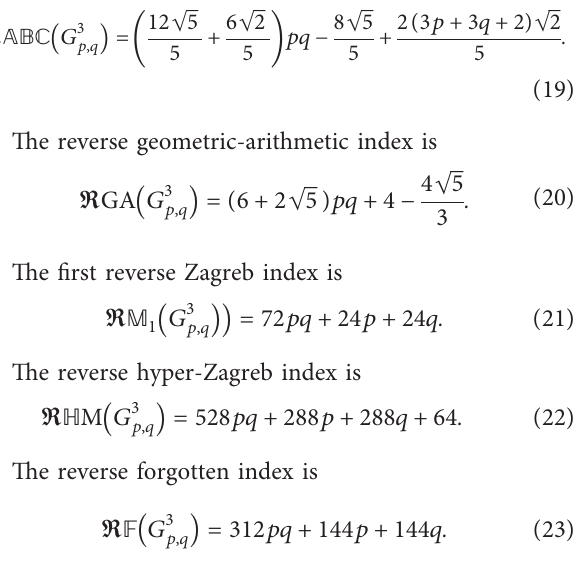
p,q for different priorities of